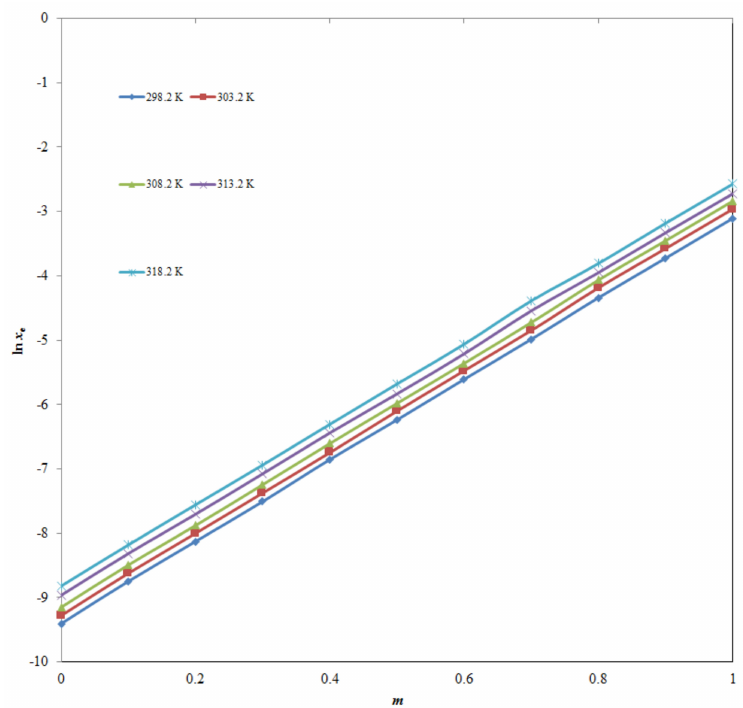
Figure 3. Impact of IPA mass fraction ( m ) on TQ logarithmic solubility at 298.2–318.2